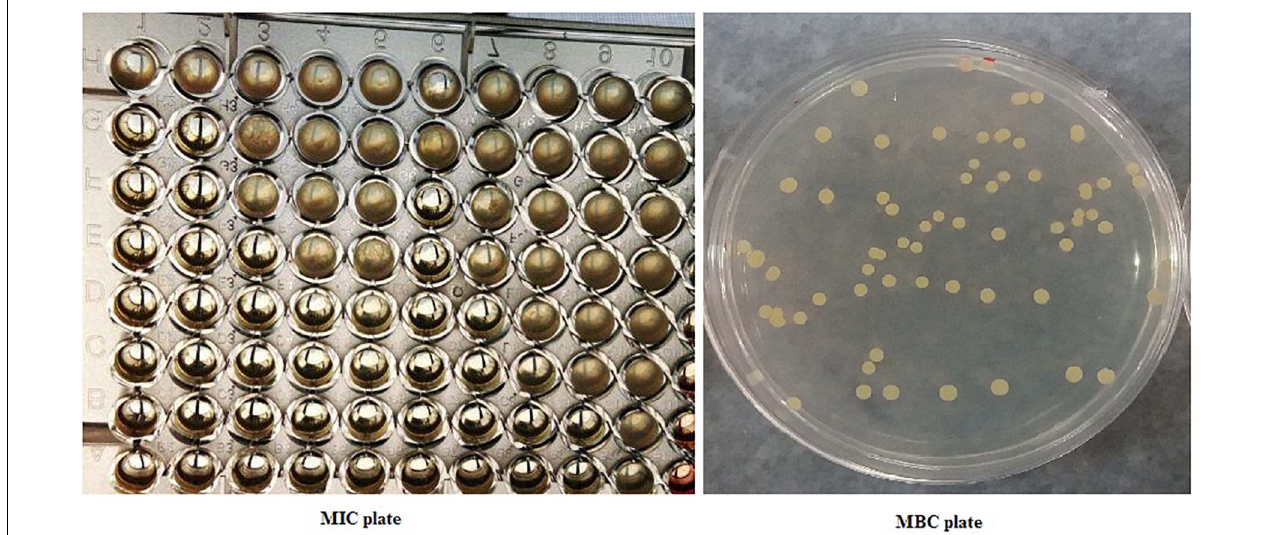
FIGURE 1 | Plates for determining minimum inhibitory concentration and minimum bactericidal